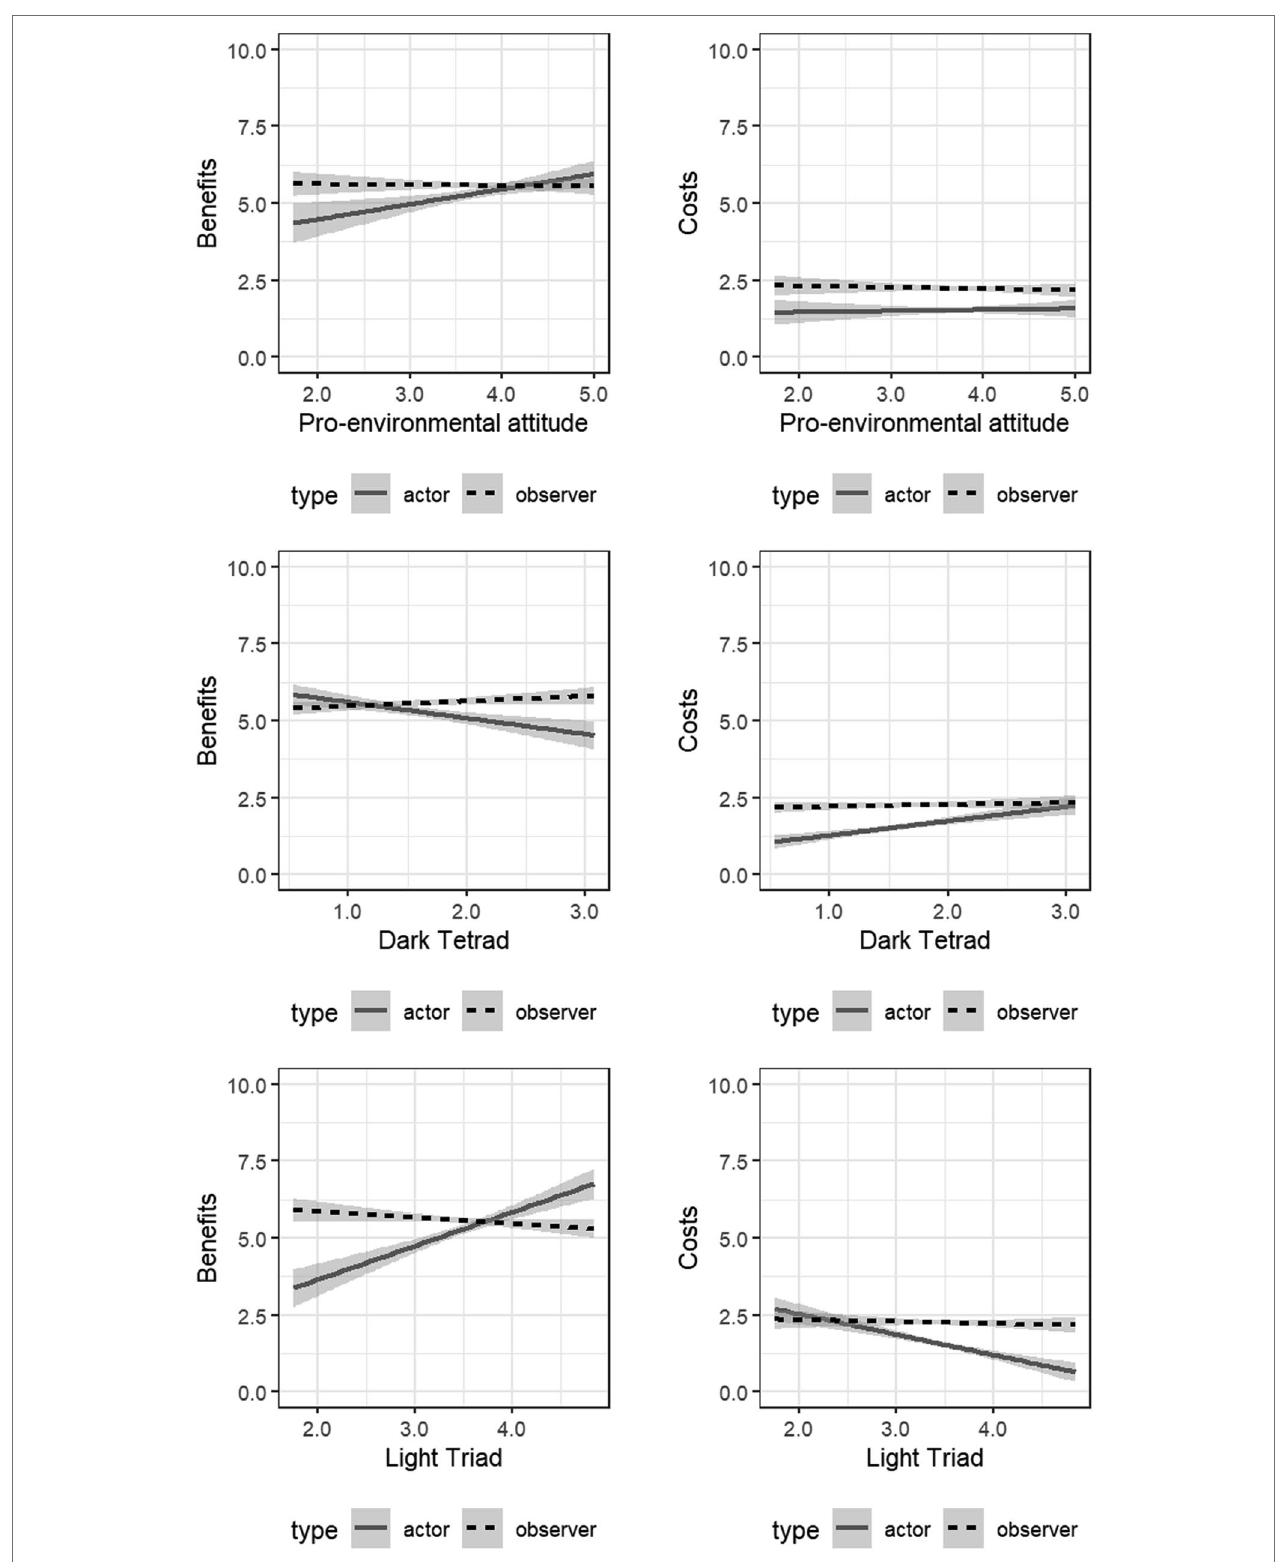
FIGURE 3 | PEB’s benefit (left) and cost (right) estimates by participants of Study 1 (“actors,” black) and Study 2 (“observers,” grey dashed), dependent on pro-environmental attitude, the dark tetrad, and the light triad of personality. The grey-shaded area displays a CI 95%